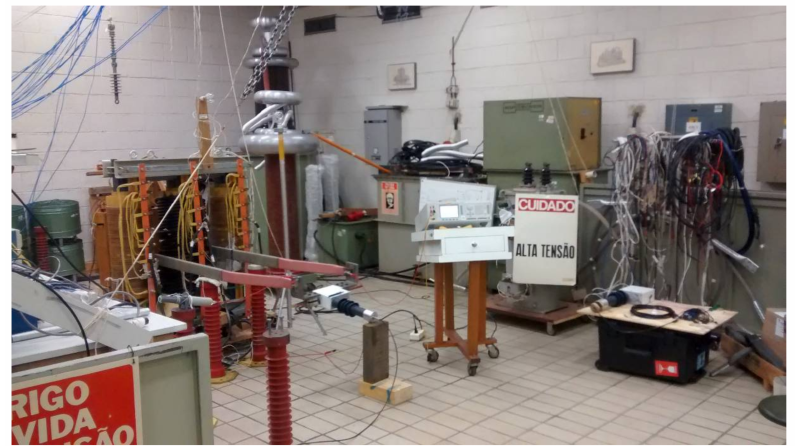
Figure 6. Set-up used to characterize the sensor in a high-voltage